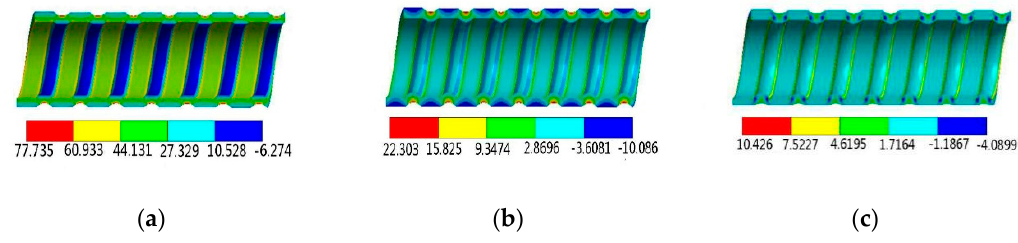
Figure 5. Three-dimensional stress distributions at the SG tubes: ( a ) Axial stress, ( b ) Circumferential stress, ( c ) Radial stress.